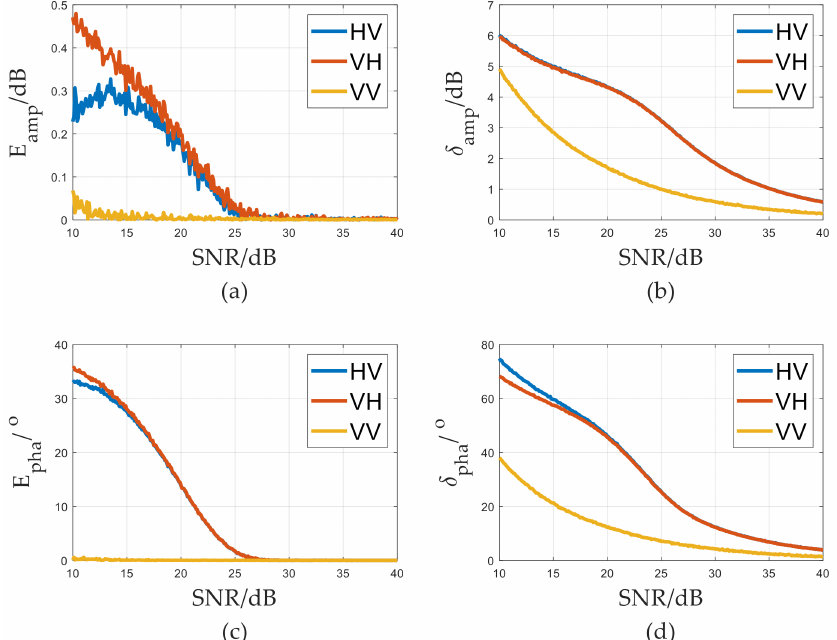
Figure 6. Relationships between SNRs and expectation, E, and standard deviation, δ , of the amplitude and phase errors of different polarization elements for STCT. ( a ) Expectations, E amp , of amplitude errors; ( b ) standard deviations, δ amp , of amplitude errors; ( c ) expectations, E pha , of phase errors; ( d ) standard deviations, δ pha , of phase